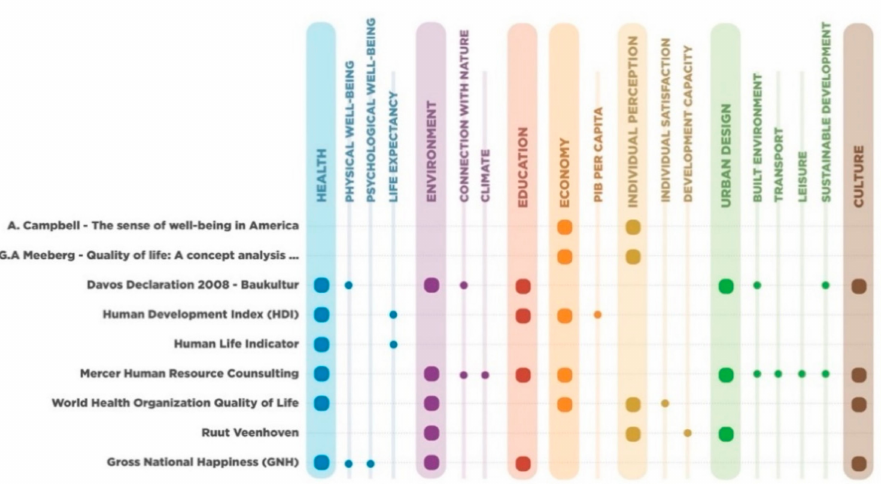
Figure 2. Summary diagram of factors influencing quality of life according to the literature of this study. Source: Compiled by the